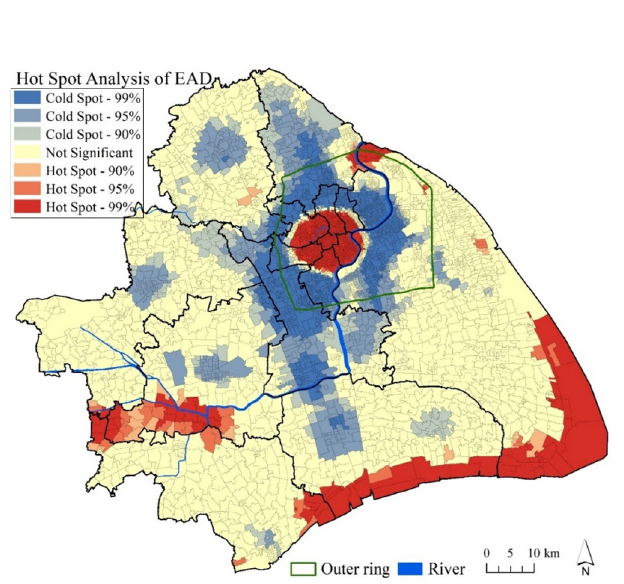
Table 3. Expected annual damages of different land-use categories